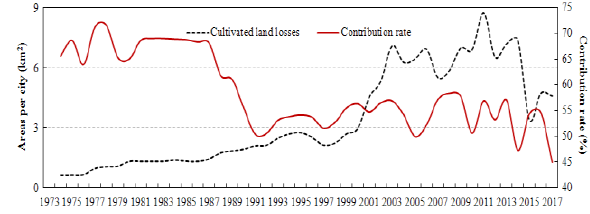
Figure 3. Cultivated land losses during 1970s-2017